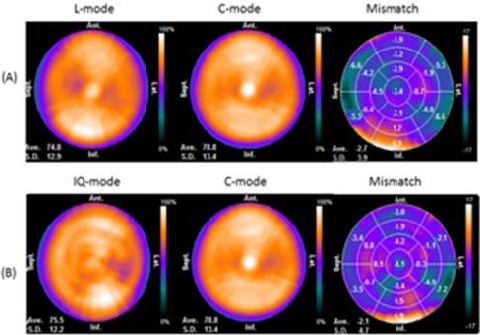
Polar map of myocardial torso phantom using 17-segment model.